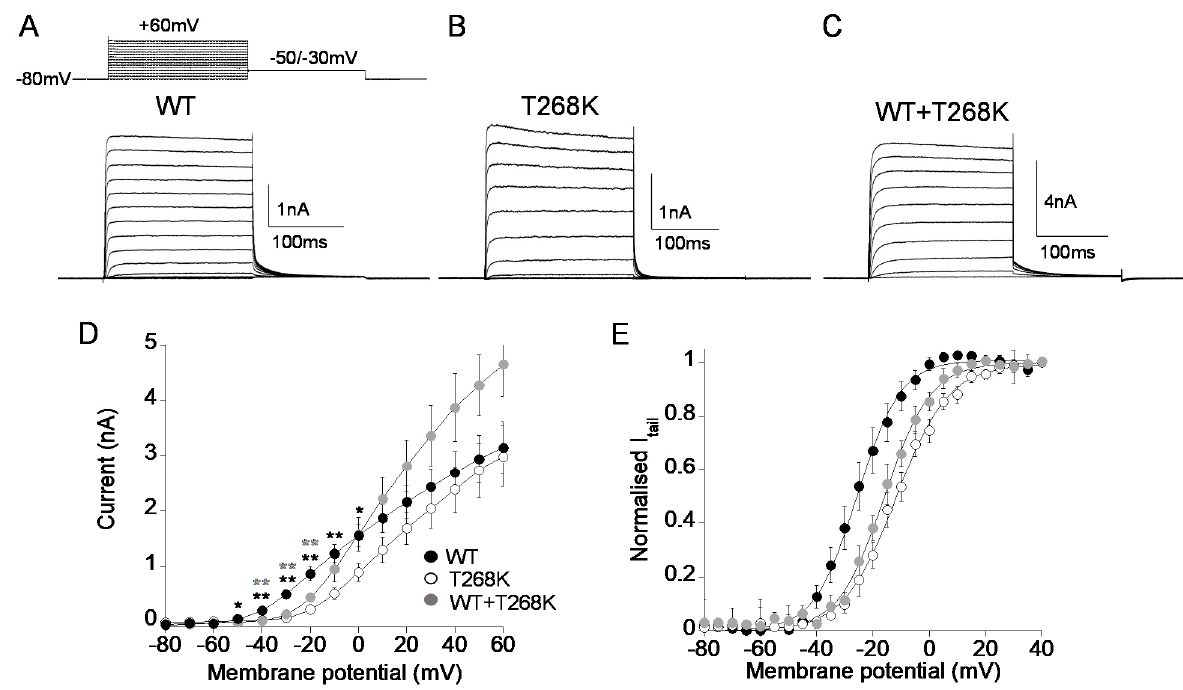
Figure 3. ( A – C ) Representative current traces evoked by 200 ms depolarizing steps from a holding potential of − 80 to +60 mV from Kv1.1 WT ( A ), T268K ( B ), and WT+T268K ( C ) channels expressed in HEK293 cells. The voltage protocol is indicated in the upper panel in ( A ). ( D ) Current–voltage relationship for Kv1.1WT (5 µ g), T268K (5 µ g), and WT+T268K (5 µ g + 5 µ g) channels. ( n = 14–36), * p < 0.05, and ** p < 0.01 with respect to WT for T268K (black) and WT+T268K (gray), respectively. ( E ) The current–voltage relationships for Kv1.1WT, T268K, and WT+T268K channels were obtained by plotting the normalized peak tail currents measured at − 50 mV (for Kv1.1WT) and − 30 mV (for Kv1.1T268K and for WT+T268K) as a function of the prepulse potentials and fitting data points with a Boltzmann function ( n = 10–18 cells). Table 1. Biophysical parameters of Kv1.1WT, Kv1.1T268K, and Kv1.1WT+Kv1.1T268K channels expressed in HEK293 cells. Voltage Dependence Kinetic of Kinetic of from of Activation Activation Deactivation